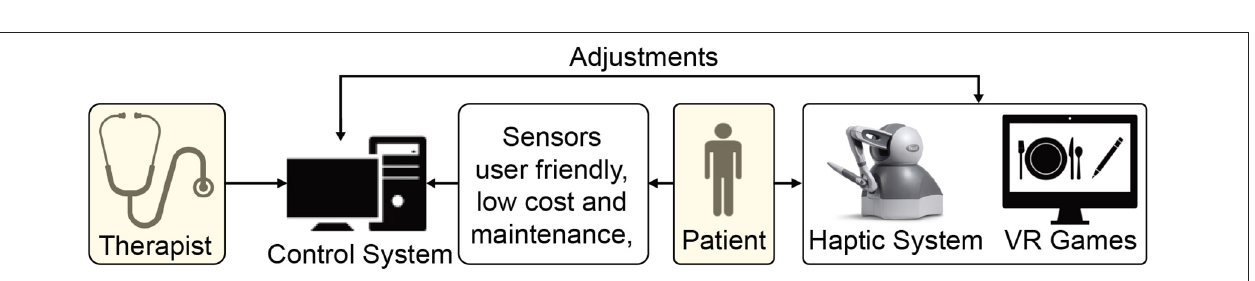
in rehabilitation. Commercially available VR headsets (Oculus Rift R (cid:13) , Microsoft HoloLens R (cid:13) , HTC Vive R (cid:13) , and the